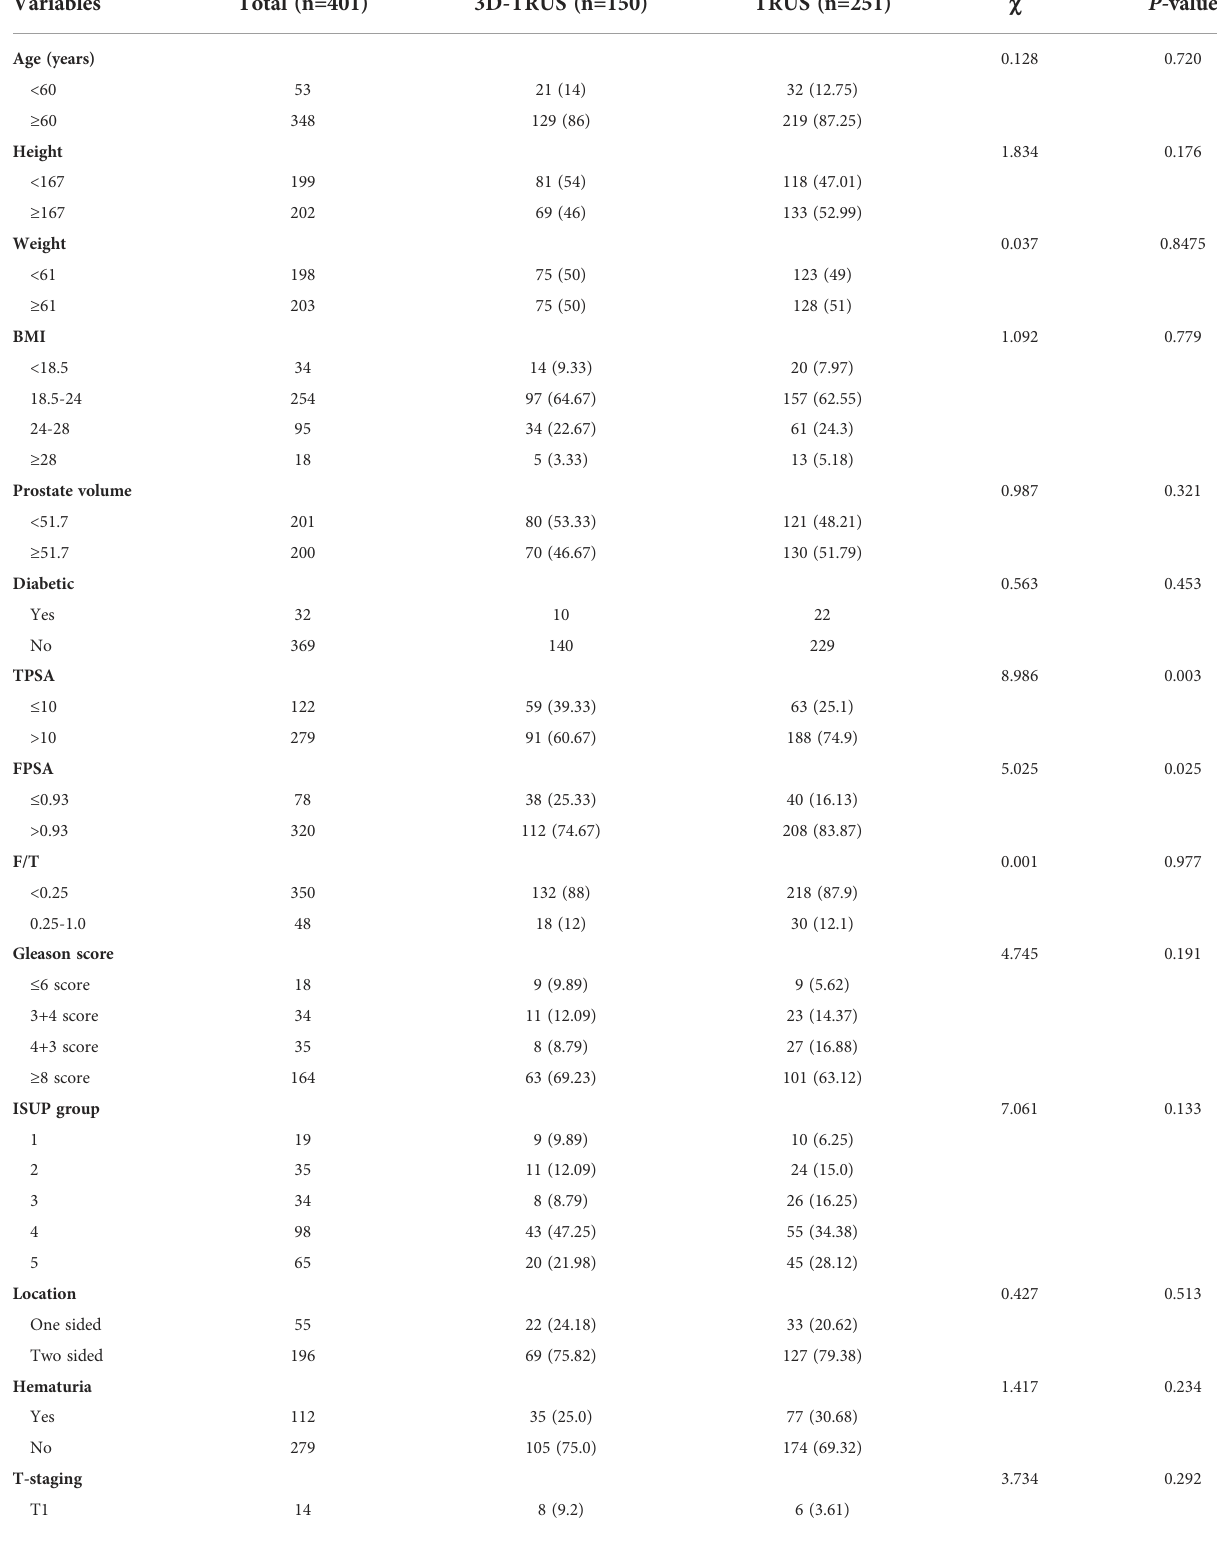
TABLE 1 Clinical and pathological characteristics of prostate cancer patients examined by 3D-TRUS and